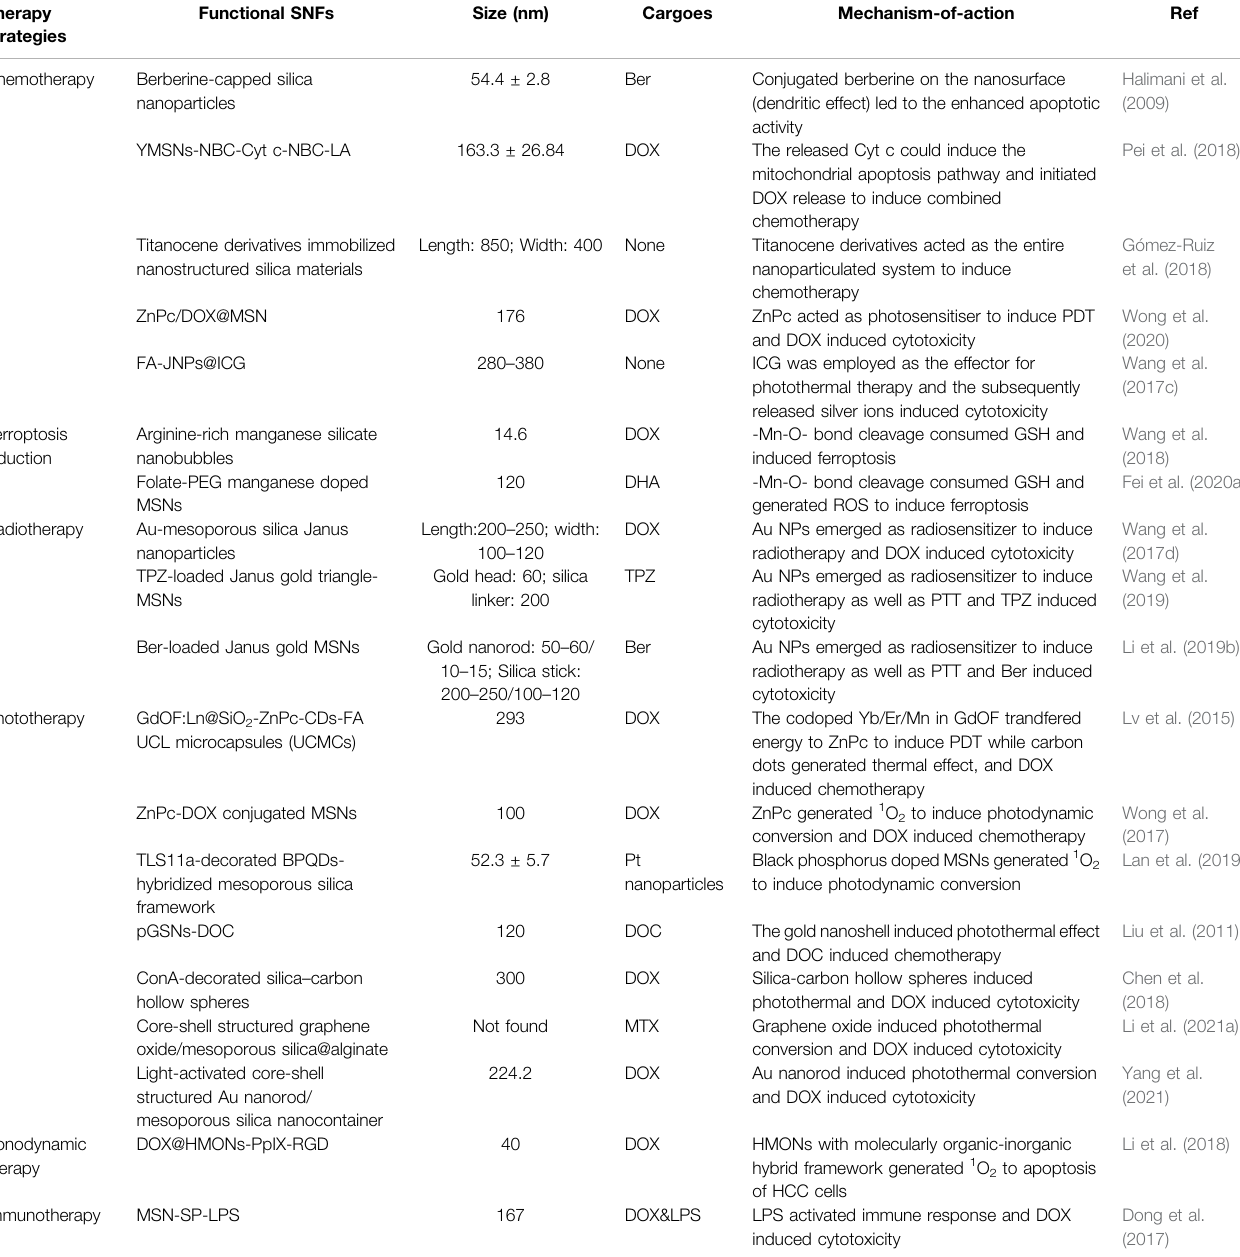
TABLE 2 | The classi fi cation of functional SNFs for hepatocellular carcinoma therapy. Therapy